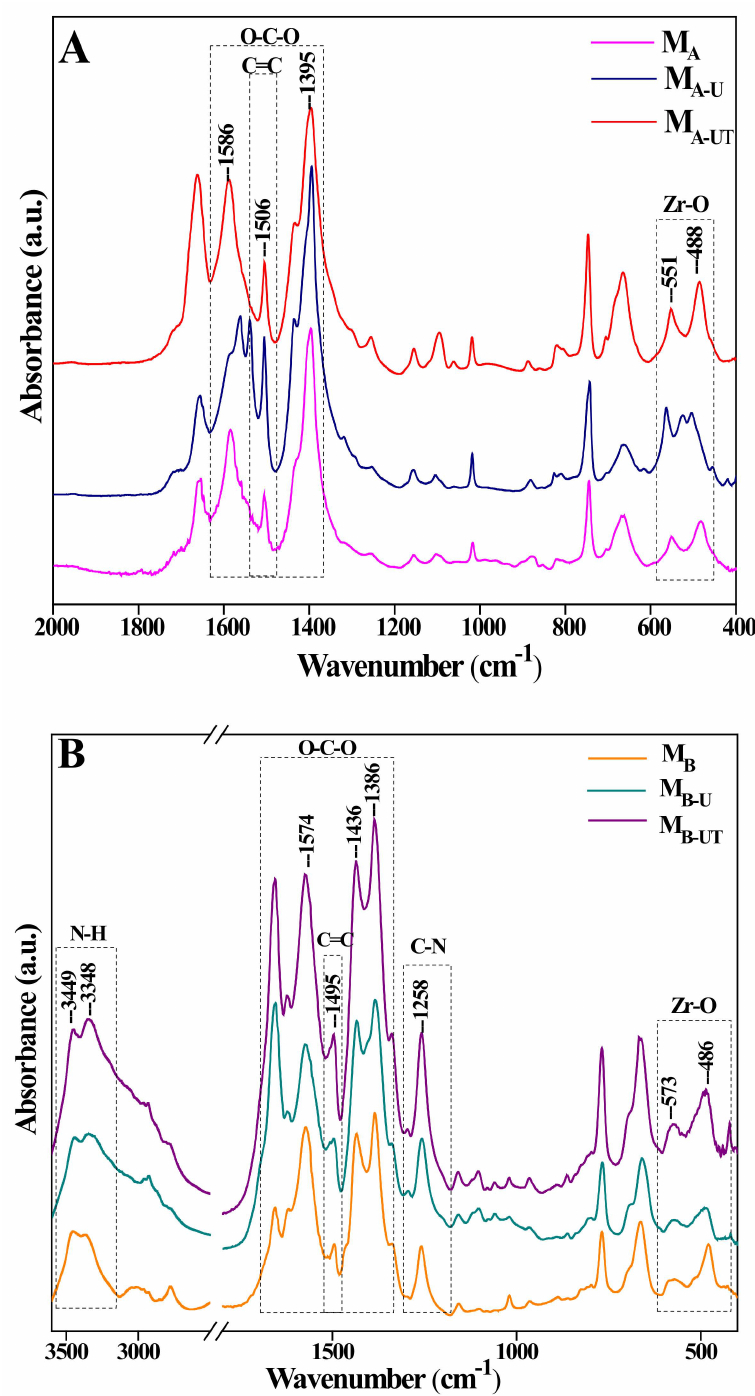
Figure 3. FTIR spectra. ( A ) UiO-66 magnetic stirring and ultrasound at room temperature and at 60 ◦ C; ( B ) UiO-66-NH 2 magnetic stirring and ultrasound at room temperature and at 60 ◦